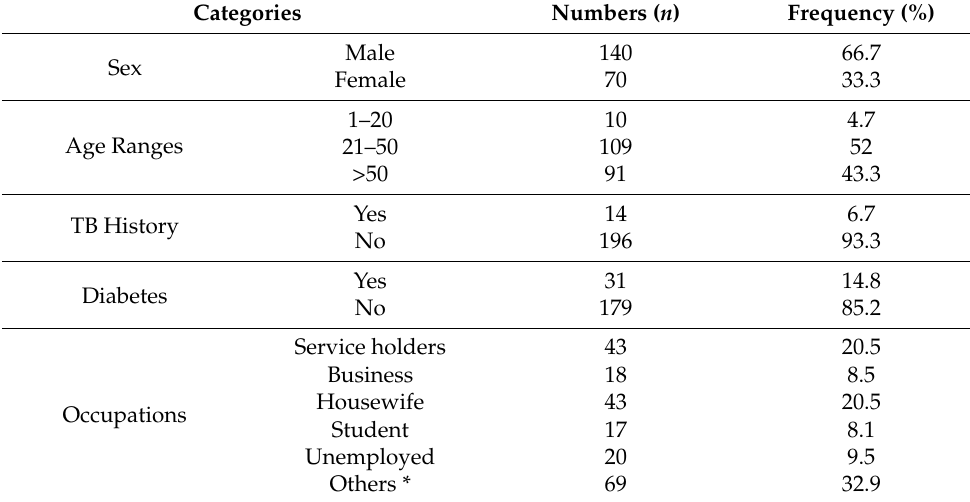
Table 1. Demographic and clinical characteristics of the enrolled participants ( n =